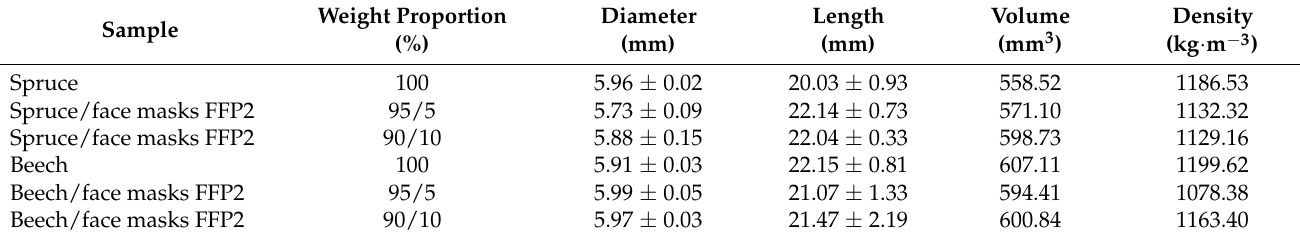
Table 3. Properties of produced